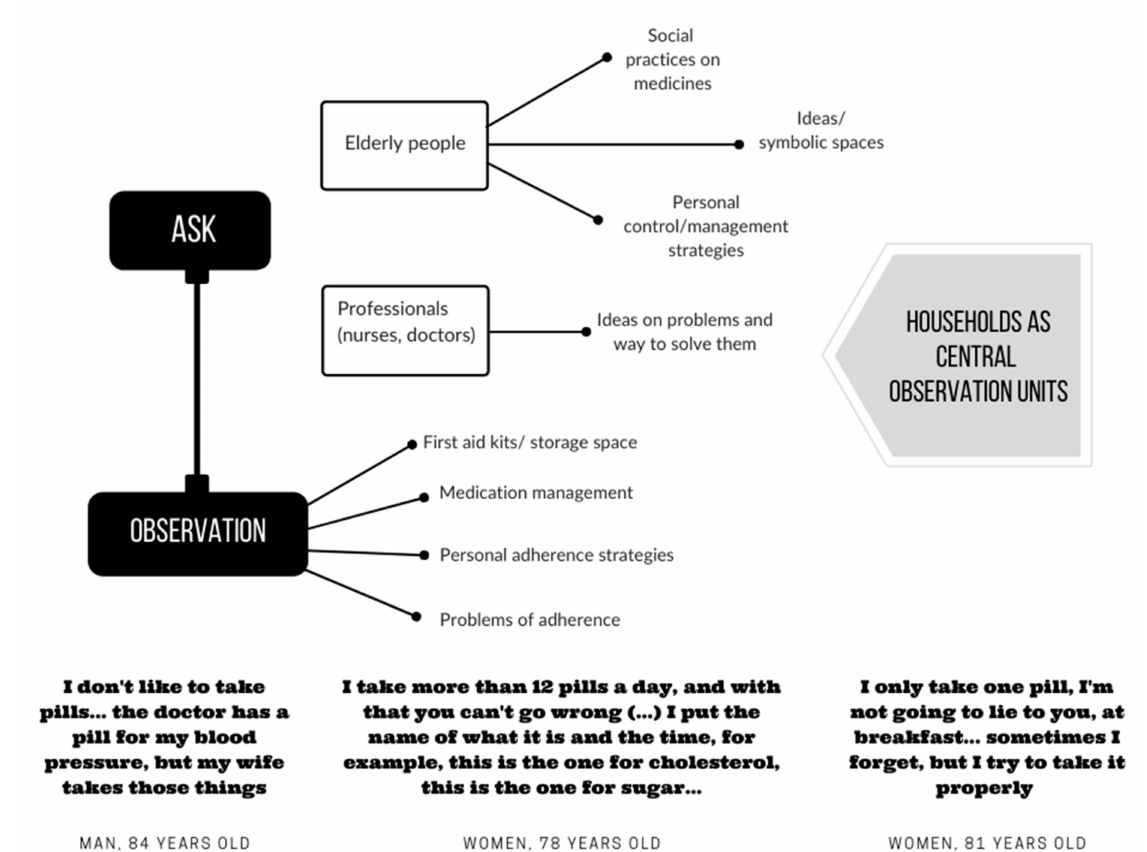
Figure 1. Qualitative data